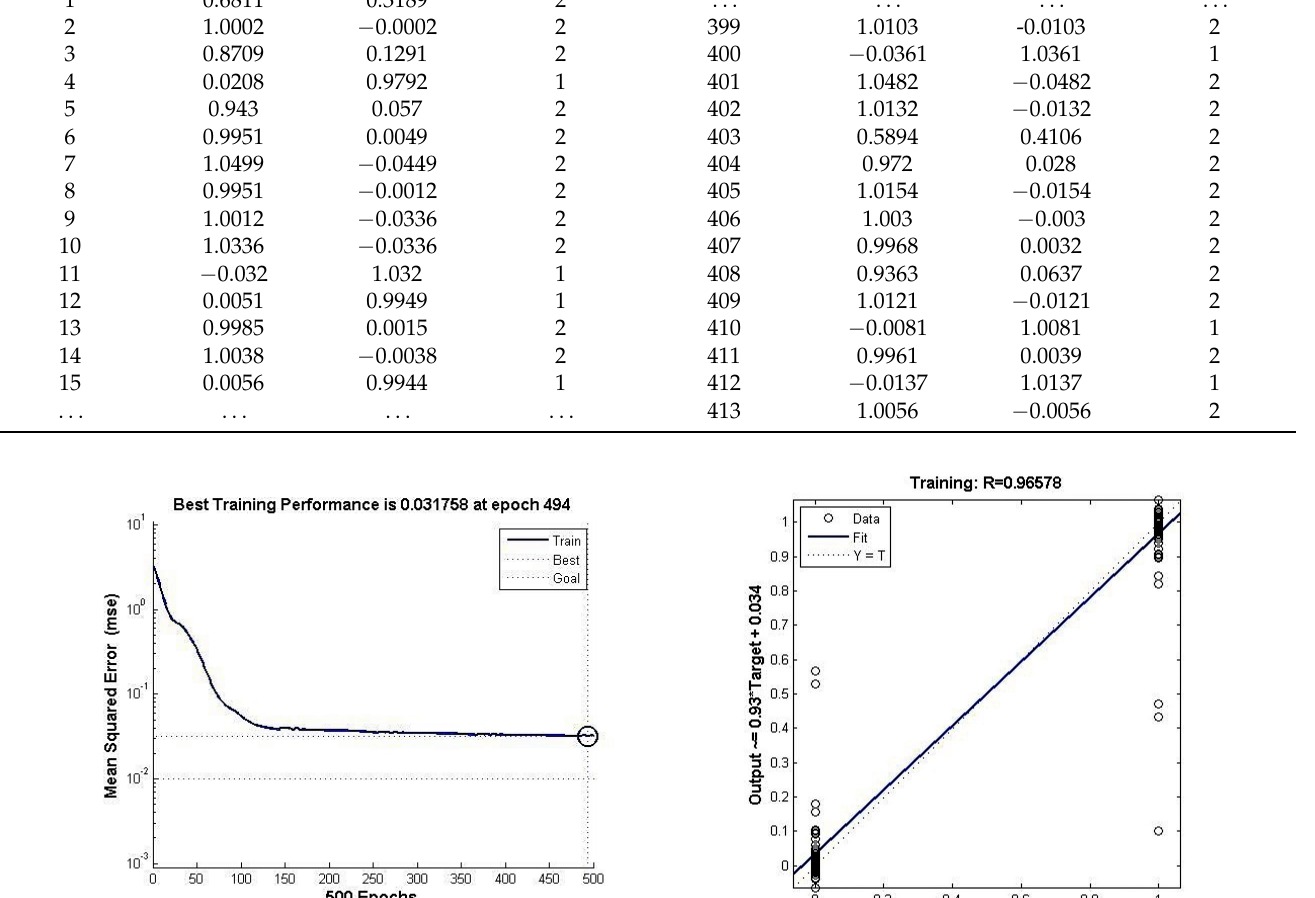
Table 1. Identification results of test set data.